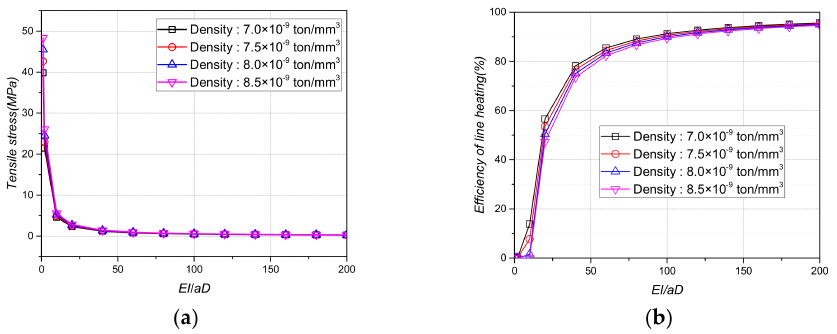
Figure 12. Tensile stress and line heating efficiency by stiffness ratio of plate and beam according to the density of the plate. ( a )Tensile stress by density of the plate; ( b ) Line heating efficiency by density of the plate.